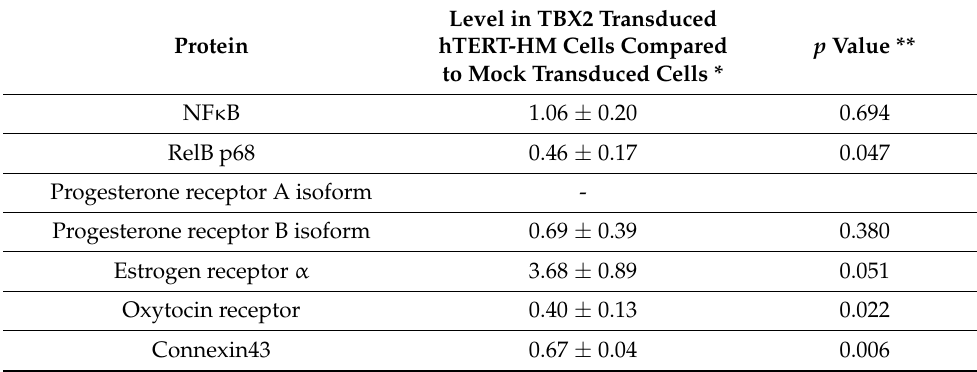
Table 4. The effect of TBX2 overexpression on labour associated proteins. Level in TBX2 Transduced Protein hTERT-HM Cells Compared to Mock Transduced Cells *